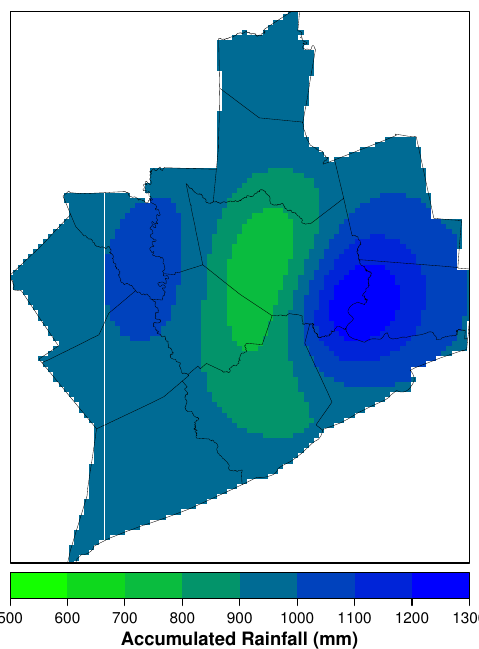
Figure 12. Interpolated rainfall map for Houston, Texas during Hurricane Harvey